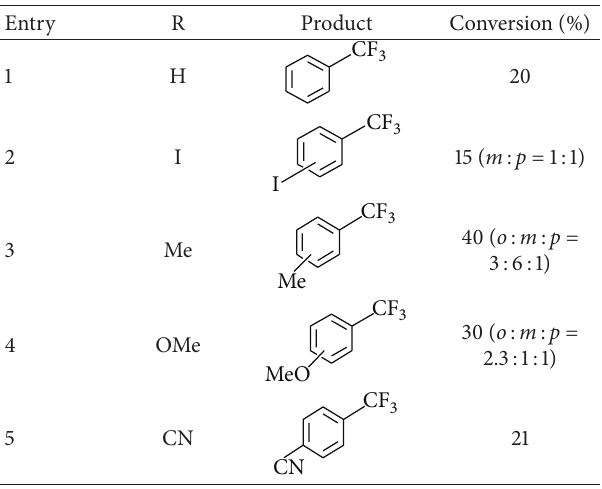
Table 5: Direct trifluoromethylation of trifluoromethanesulfonyl chloride with benzene derivatives a (see Scheme